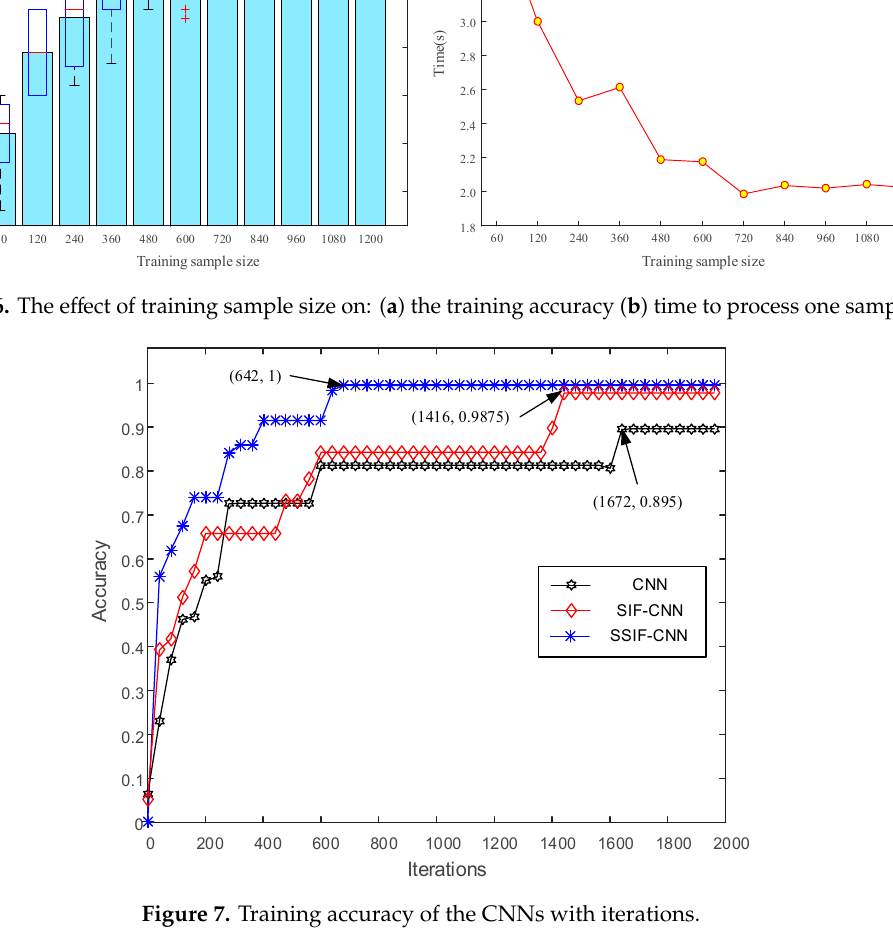
Figure 7. Training accuracy of the CNNs with iterations.